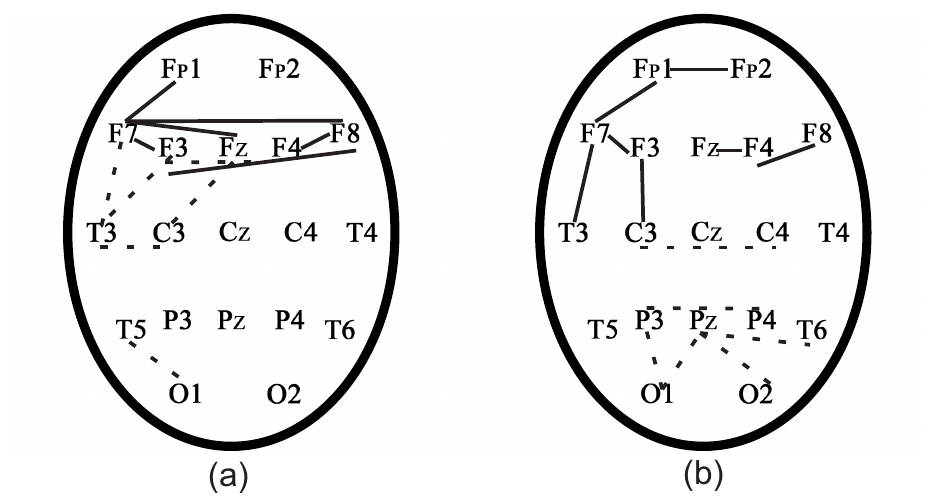
Figure 19. Phase-connected pairs of EEG channels of a patients with TBI before (dotted lines) and after the rehabilitation (solid lines) in the CT2 test. ( a ) Patient 1. ( b ) Patient 2.